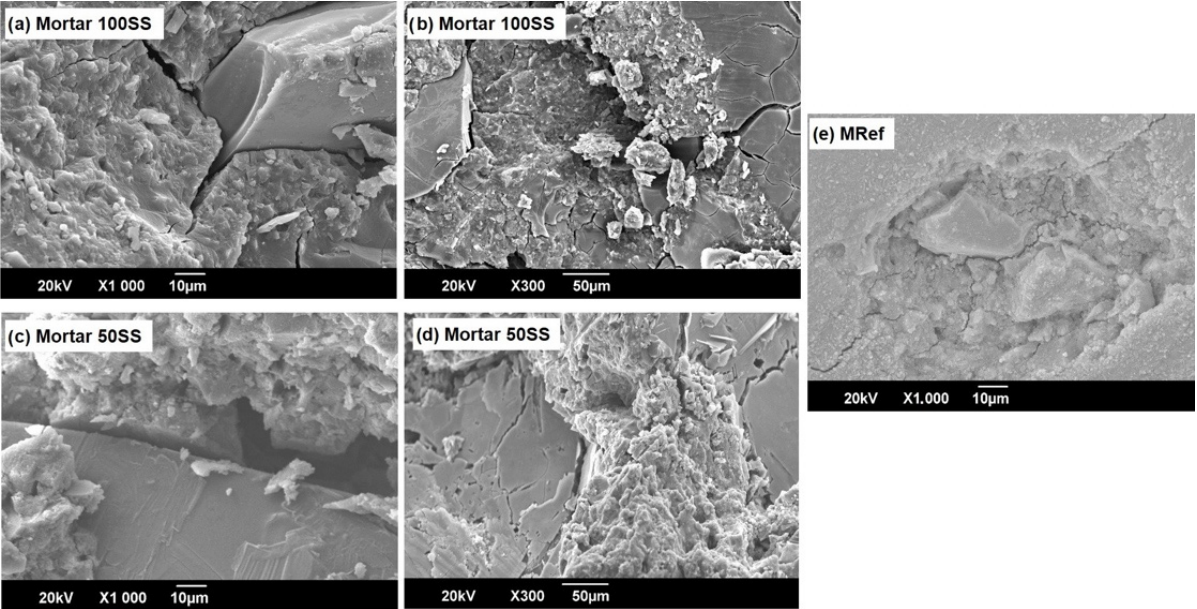
Figure 6. SEM images of mortar based on M11 paste with different SS content using G as a fine aggregate ( a – d ) and ( e ) mortar made with M11-100SS and natural aggregate (river